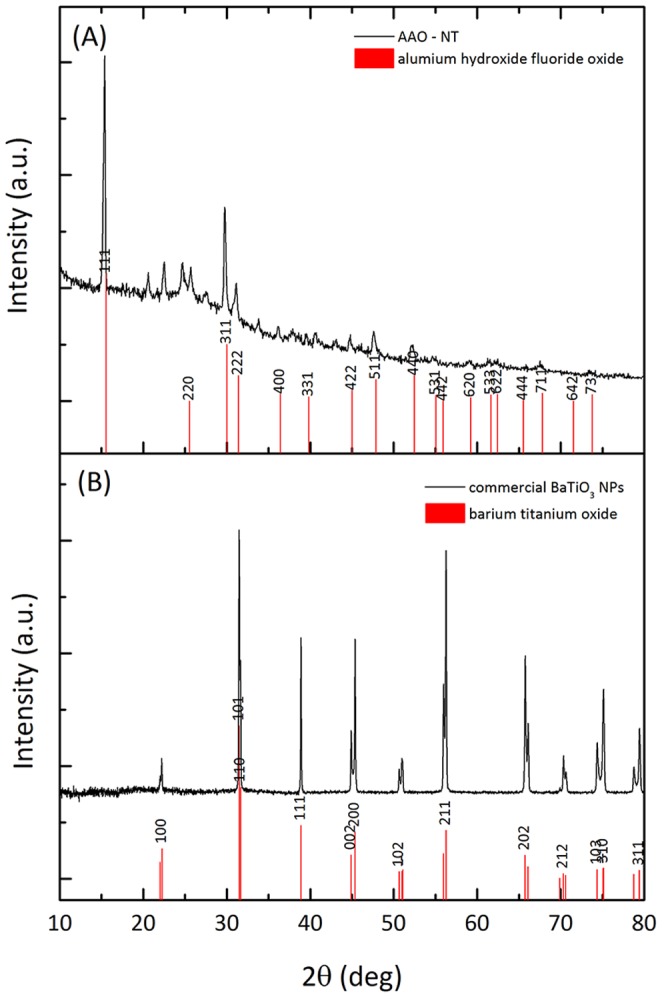
XRD spectra recorded from the AAO-NT (A) and crystalline (tetragonal structure) BaTiO3 NP (B).